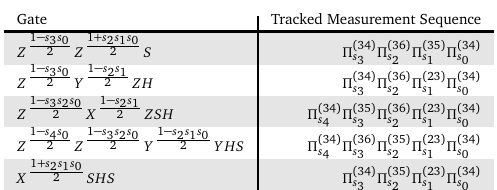
Table 15: Pauli gate corrections tracked for the corresponding single-qubit gates implemented using Majorana-Pauli tracking methods. The implicit action on the 1 − sns 0 Π ( 34 ) ancillary qubit is X for sequences of length n 2 s 0